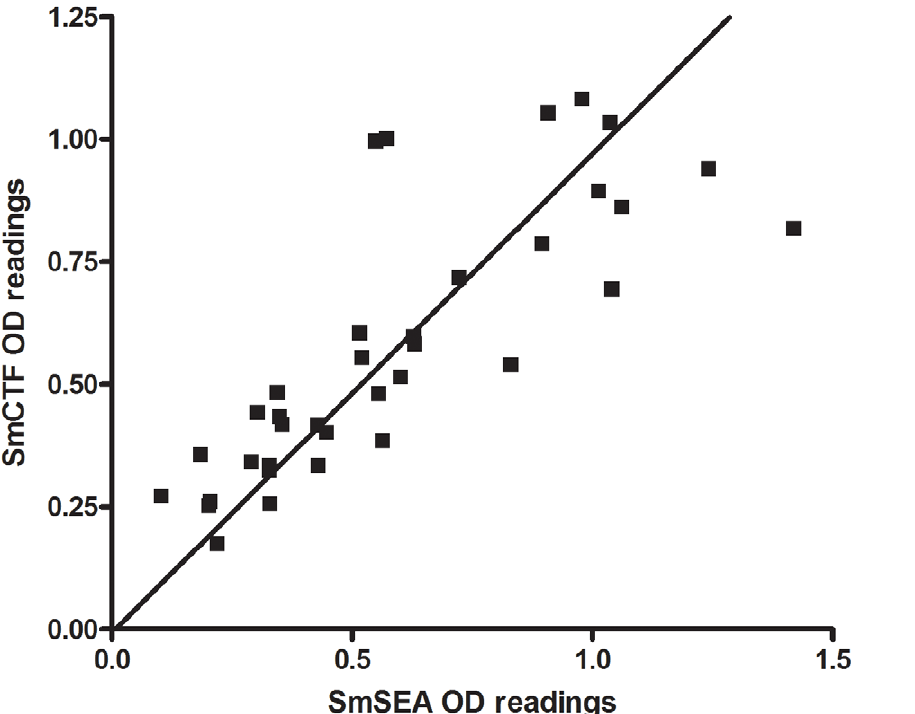
Figure 8. LSTM: correlation between S.mansoni cercarial transformation fluid (SmCTF) and soluble egg antigen (SmSEA) in ELISA. Results for sera from patients suspected to be infected with schistosomes, but not identifiable as either S. mansoni or S. haematobium .